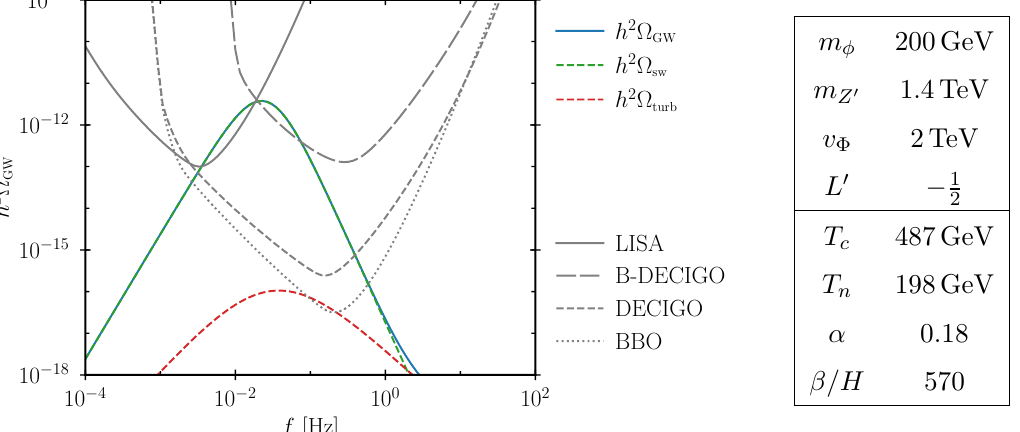
Figure 19 . GW spectrum (blue line) from the U(1) ‘ breaking phase transition for m (cid:30) = 200 GeV and m Z 0 = 1 : 4 TeV. The contributions from di(cid:11)erent production mechanisms are indicated by the dashed lines. The gray lines indicate the (power-law integrated) sensitvity of LISA (solid), B-DECIGO (long dashed), DECIGO (dashed), and BBO